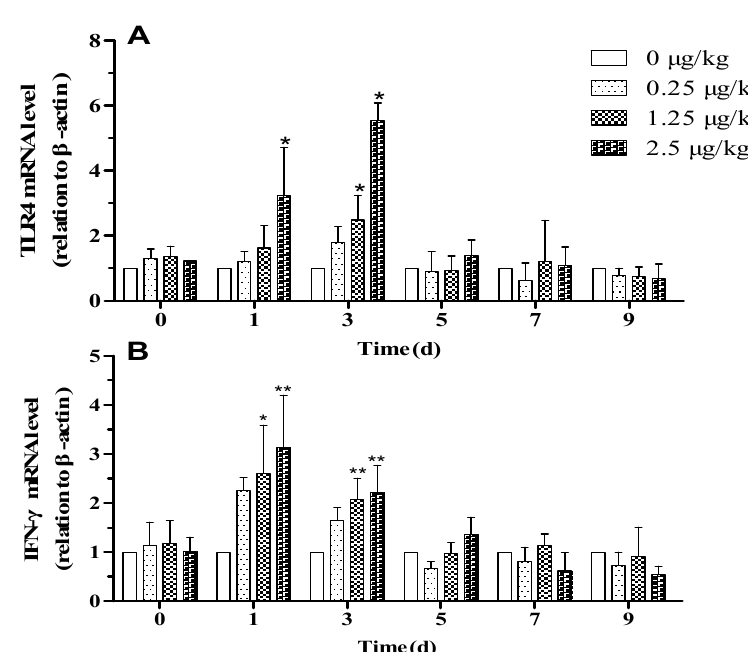
Figure 3. Effect of 0.25, 1.25, and 2.5 μ g/kg LPS on expression of inflammatory markers in blood of lambs. ( A ) Toll-like receptor-4 ( TLR4 ) and ( B ) Interferon- γ ( IFN- γ ). The values are normalized to control values and expressed as means ± SD. * p < 0.05, ** p < 0.01, and *** p < 0.001, compared with the control group.